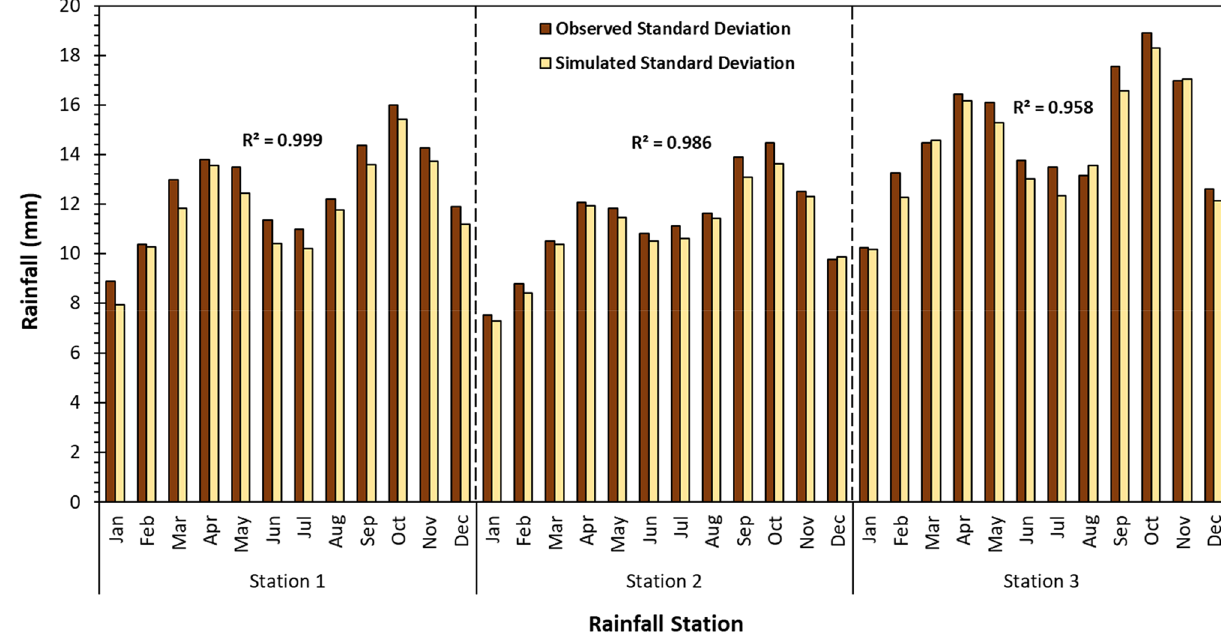
Fig. 3 Comparison of observed and model-simulated standard deviation at three stations